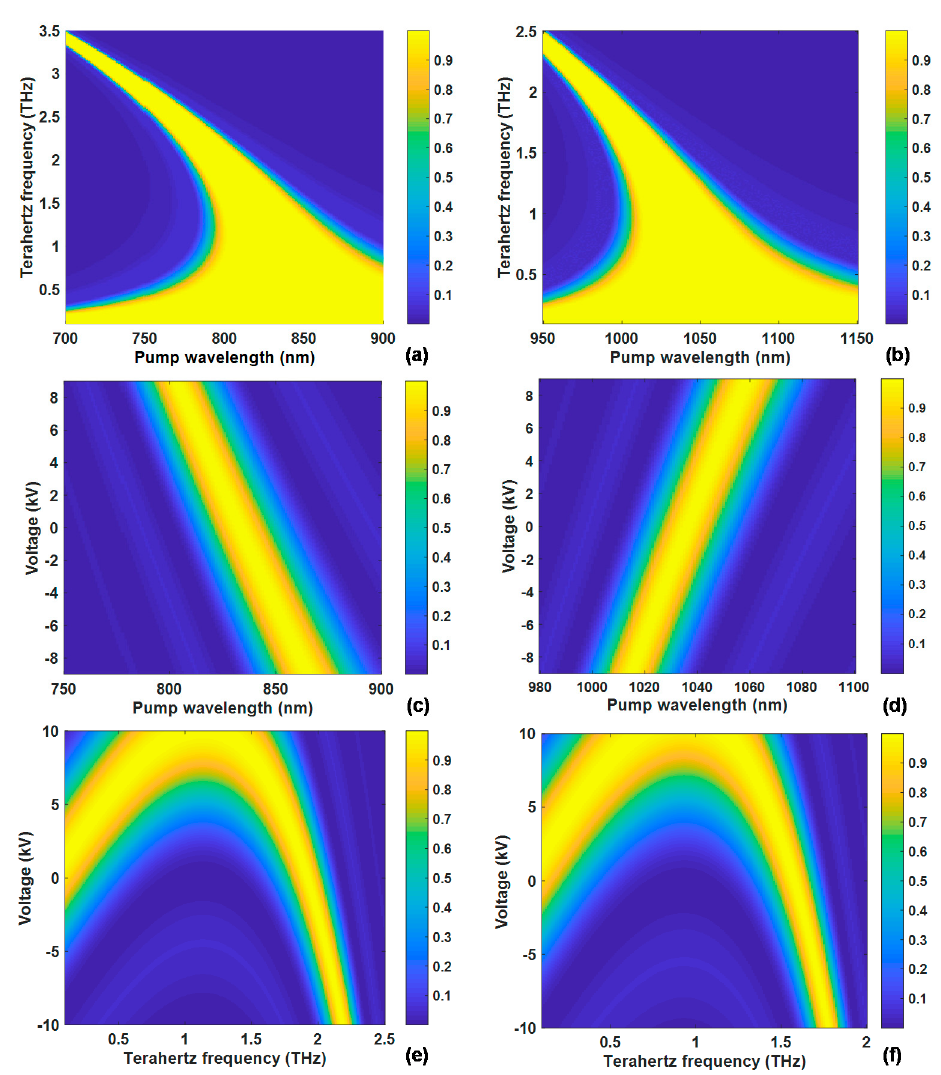
Figure 3. Relative PM efficiency of widely tunable monochromatic terahertz generation by collinear PM in ZnTe and CdTe crystals via the electro ‐ optic effect: ( a , c , e ) are for ZnTe; ( b , d , f ) are for CdTe; ( a , b ) show the perfect PM regions by applying a suitable voltage; ( c , d ) demonstrate the relationship between voltage and pump wavelength for phase ‐ matched 1 THz generation; and ( e , f ) represent the relationship between voltage and terahertz frequency with fixed pump wavelengths of 800 nm and 1010 nm, respectively.